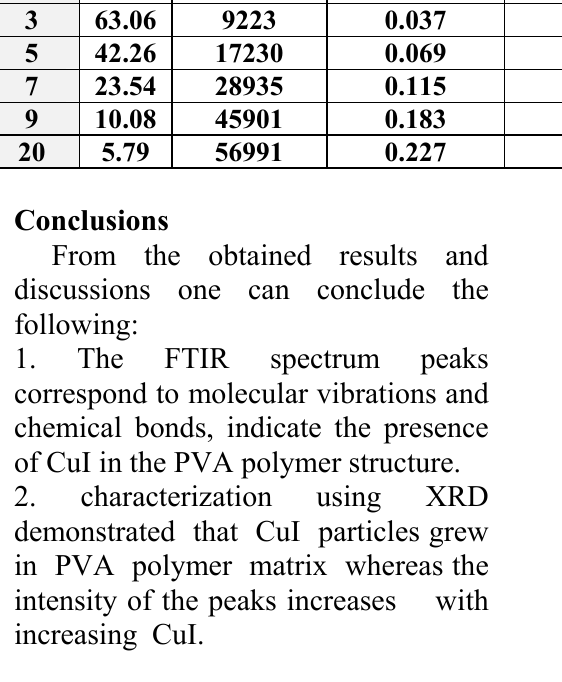
Table 4: The values of optical Constants for of PVA\CuI polymer composites at λ =550 nm. CuI %